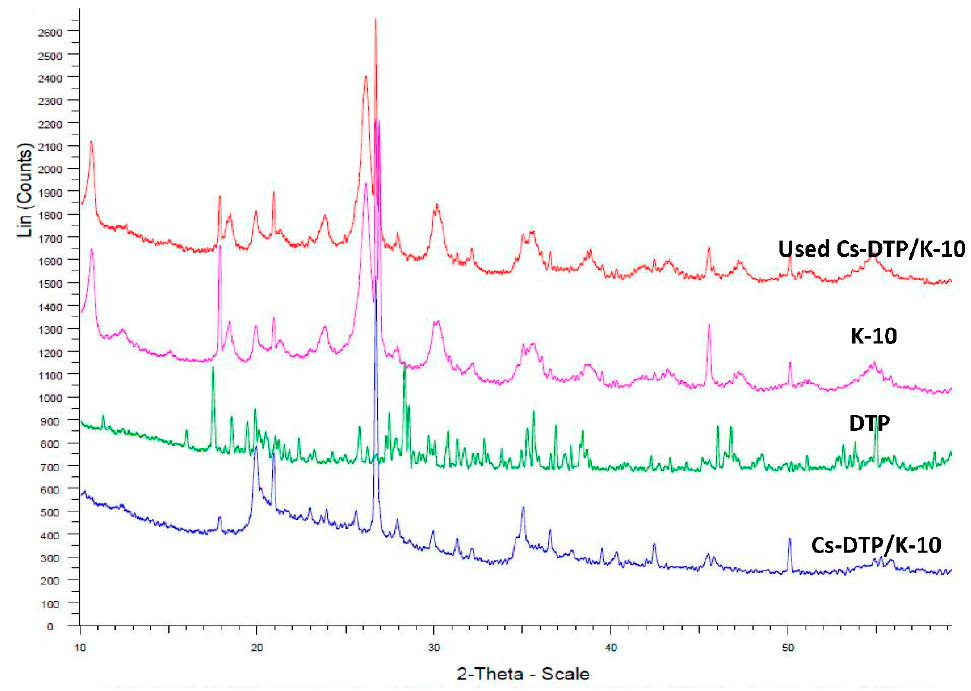
Figure 4. XRD patterns of Cs-DTP/K-10, Bulk DTP, K-10, and used catalyst.